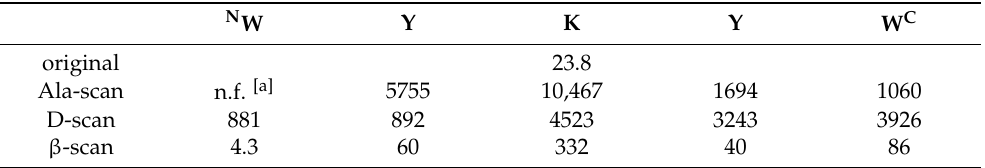
Table 1. Binding affinities (K D [nM]) of the WYKYW analogues to ganglioside GM1. The